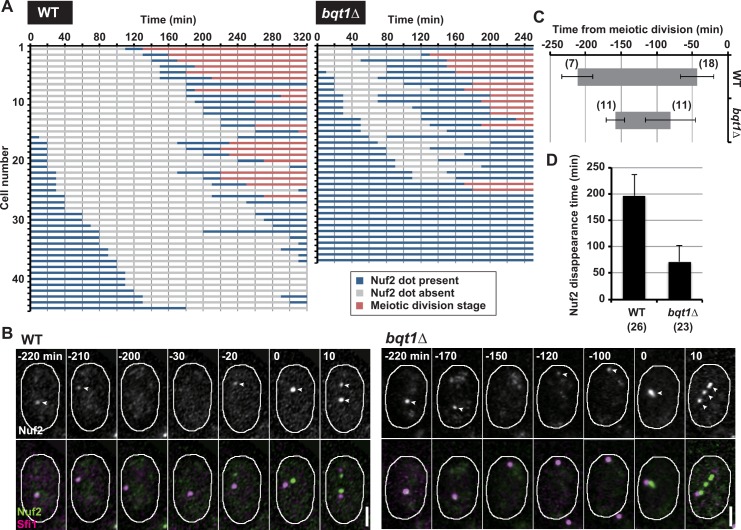
Live cell analysis of Nuf2 localization in haploid meiotic cells.(A) Live cell analysis of Nuf2 localization in haploid wild-type and bqt1Δ cells. Cells were induced to enter meiosis by incubation in nitrogen-free medium at 30°C. After incubation for 4 h, they were observed every 10 min at 25°C. Each bar indicates Nuf2 localization in each meiotic cell. Blue and gray bars indicate periods when Nuf2 dots were present and absent, respectively, and red bars indicate the meiotic division stage. (B) Changes in Nuf2 localization in haploid wild-type and bqt1Δ cells during meiosis. Numbers show time from the start of meiosis I, and arrowheads show Nuf2 signals. White bars: 2 μm. (C) Nuf2 disappearance period relative to the start of meiosis I in haploid cells (grey bars). (D) Duration of Nuf2 disappearance in haploid meiosis. Numbers in parentheses and error bars indicate the number of examined cells and standard deviation, respectively.